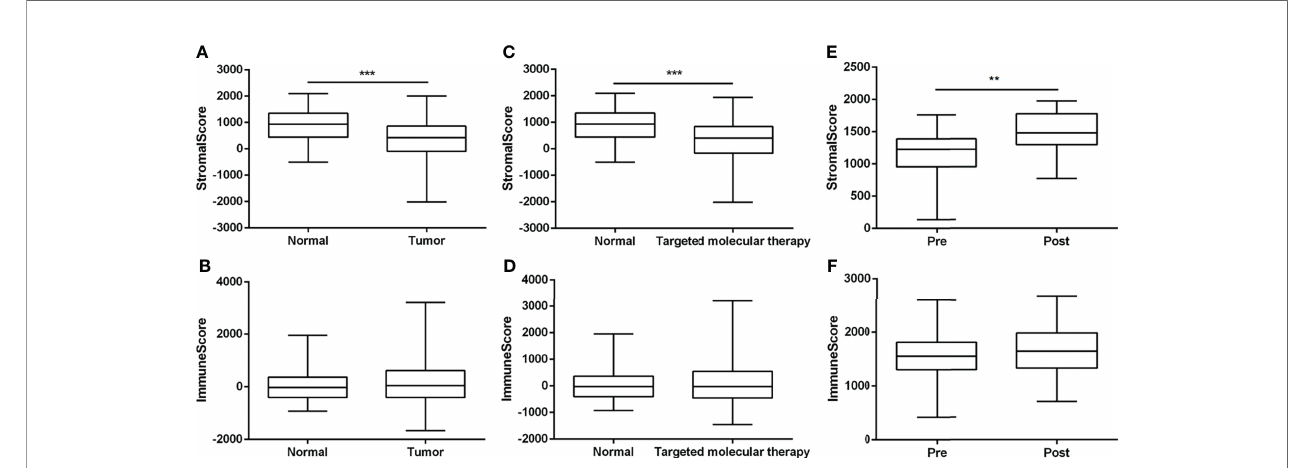
FIGURE 1 | The assessment of stromal scores and immune scores using the ESTIMATE algorithm. (A, B) The stromal and immune scores between nontumor tissues and breast tumor tissues based on the TCGA-BRCA dataset. (C, D) The stromal and immune scores of 99 normal samples and 467 tumor samples with the treatment of targeted molecular therapy, based on TCGA-BRCA dataset. (E, F) The stromal scores and immune scores between breast tumor tissues whether treated by trastuzumab or not, based on the GSE114082. The data were presented as the mean ± SD, normal vs. tumor, pretreatment vs. posttreatment. ** p < 0.01; *** p <